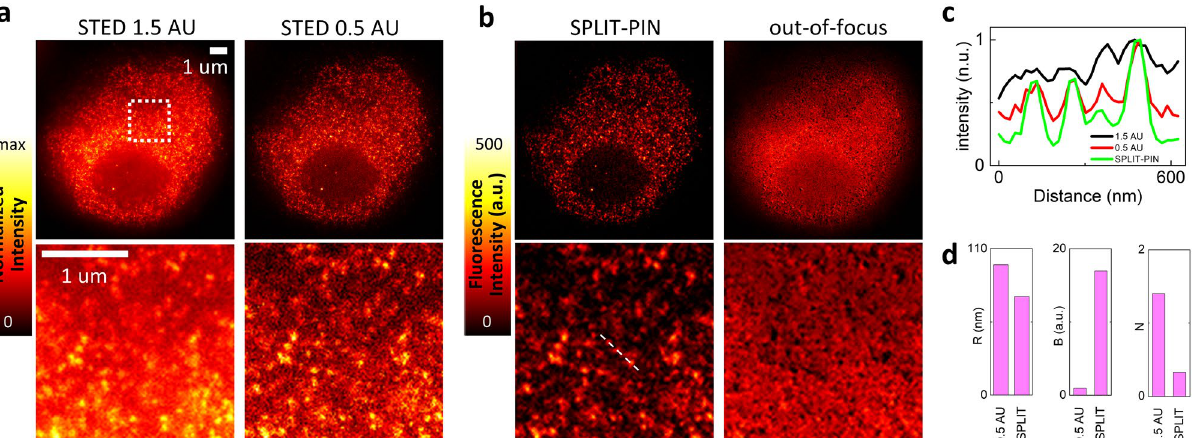
parameter N represents the relative noise variance, related to the noise level in the image. For the equatorial section (Fig. 2e), QuICS reveals that the SPLIT-PIN image has comparable resolution (R = 468 nm), higher contrast (B = 360) and comparable noise level (N = 0.24) compared to the confocal image acquired at 0.2 A.U. (R = 480 nm, B = 140, N = 0.25). For the bottom section (Fig. 2f), QuICS reveals that the SPLIT-PIN image has comparable resolution (R = 517 nm), higher contrast (B = 350) and comparable noise level (N = 0.19) compared to the confocal image acquired at 0.2 A.U. (R = 514 nm, B = 200, N = 0.19). In both cases SPLIT-PIN provides a higher contrast compared to the image of smaller pinhole size.